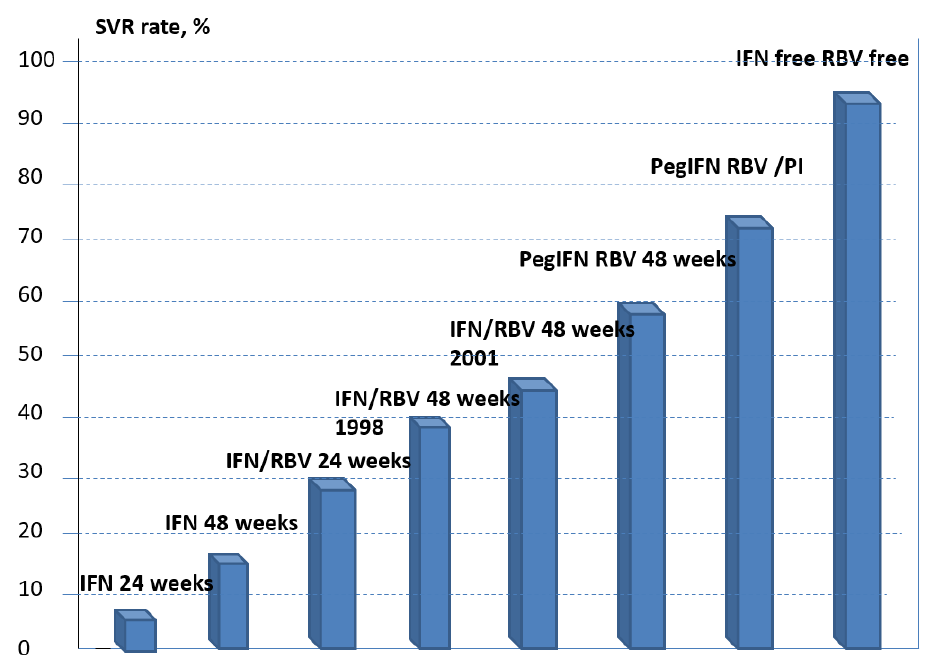
Figure 2. Antiviral therapy of HCV—a changing scenario.